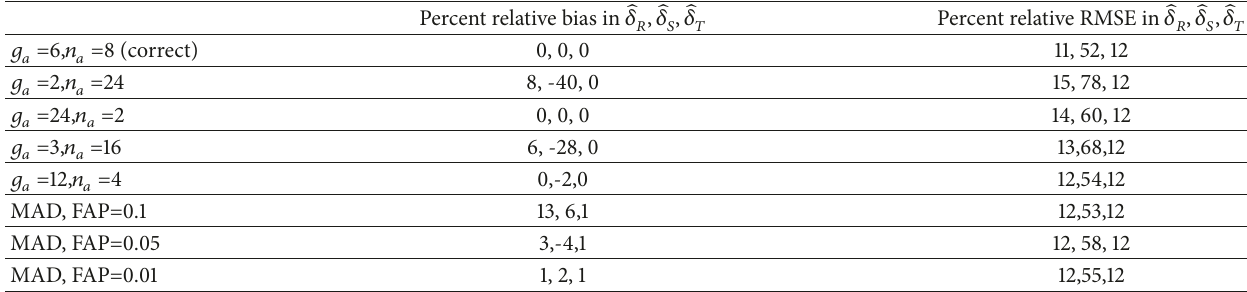
Table 2: Performance of estimators of estimates of